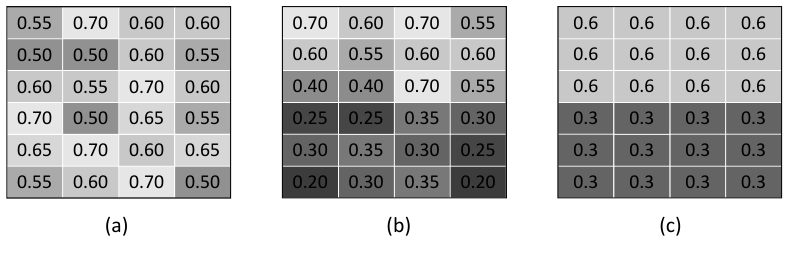
Figure 10. Example of three different types of prior information for low-cost labeling: ( a ) everywhere smooth; ( b ) piecewise smooth; ( c ) piecewise